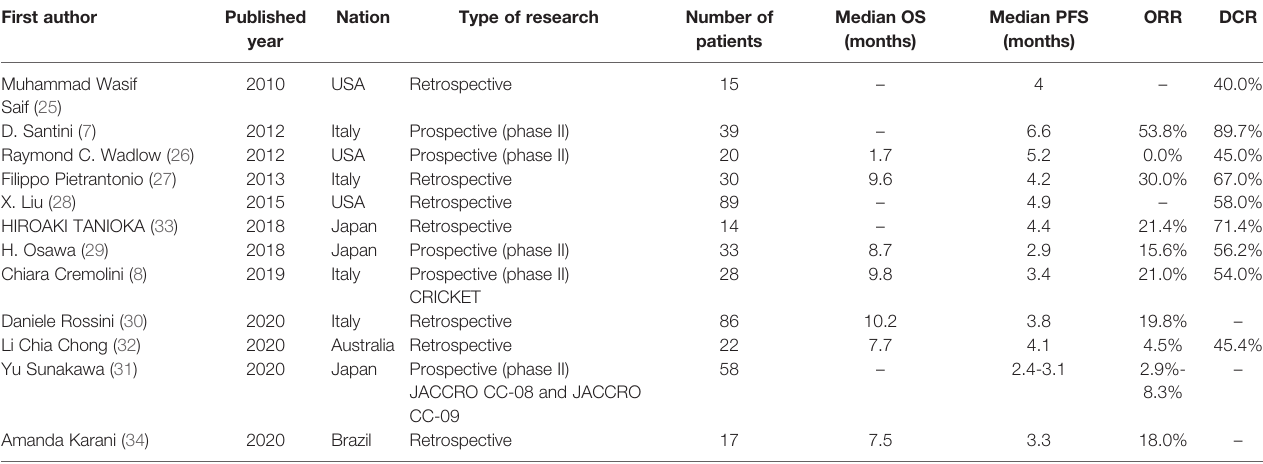
TABLE 1 | Literature of reported clinical trials of rechallenge with anti-epidermal growth factor receptor (EGFR) therapy with panitumumab or cetuximab-based therapy for patients with metastatic colorectal